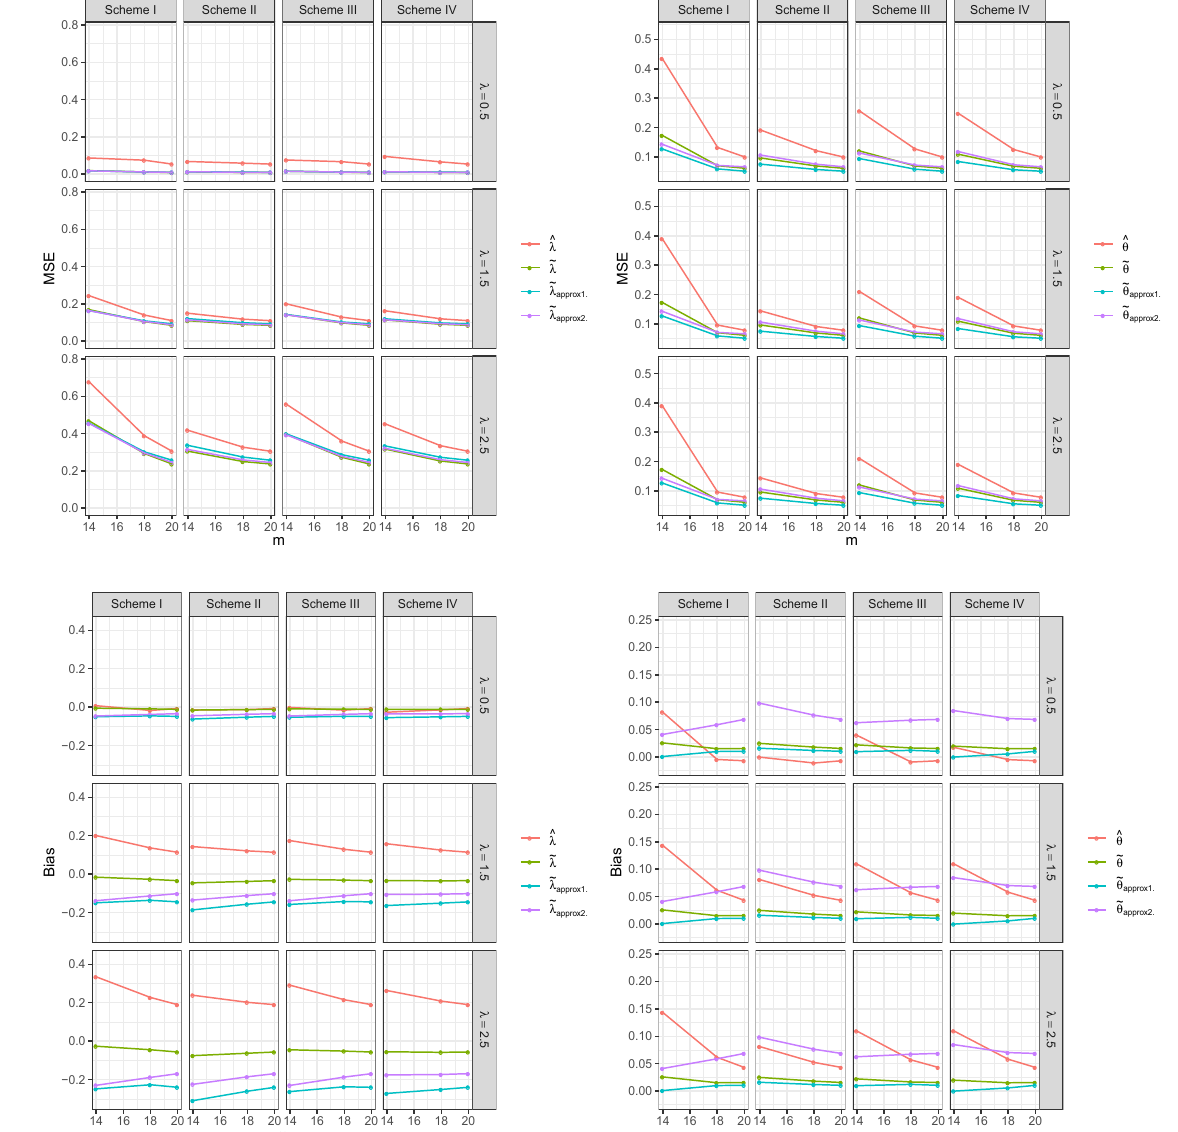
Figure 1. The MSEs and biases of the estimators for the sample size n =